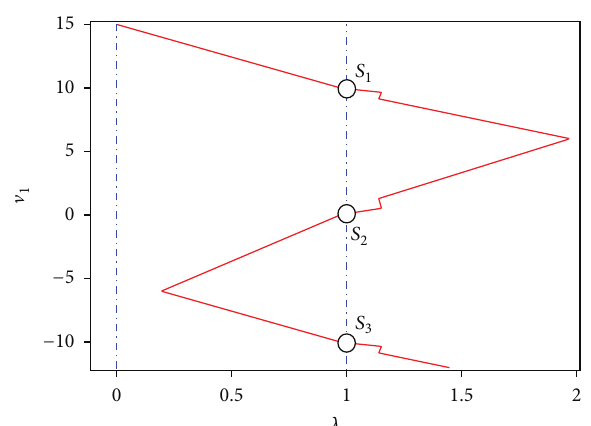
Figure 7: Projection 𝜆 - V 1 of homotopy path for